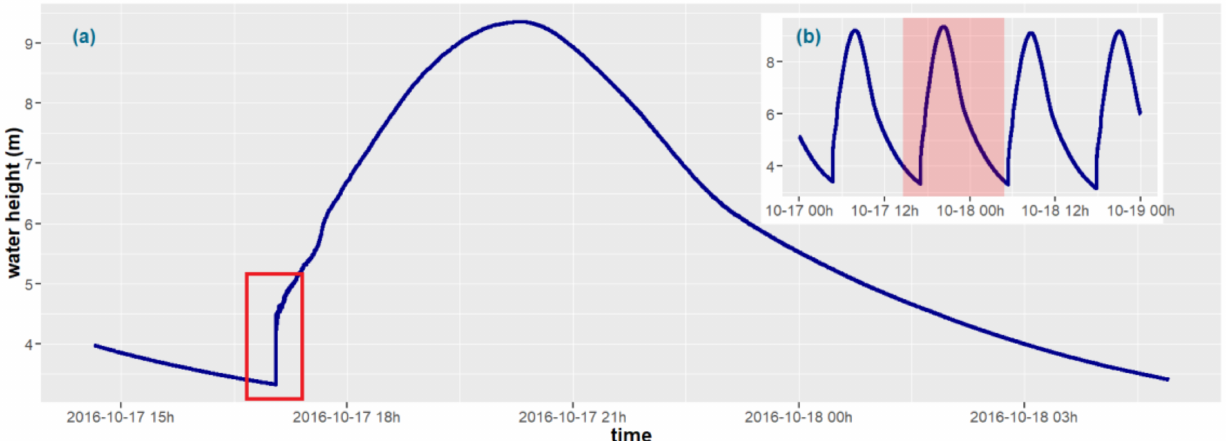
Figure 2. 1-Hz resampled pressure water level time series of the Garonne River at Podensac. ( a ) During the GNSS-R SNR acquisition with red rectangle indicating tidal bores; ( b ) during four consecutive tide periods. These figures are representative of the entire pressure water level time series and do not show the tidal oscillations over a longer period, as the acquisition was performed during spring tides only when both the tidal range is maximum and tidal bores can